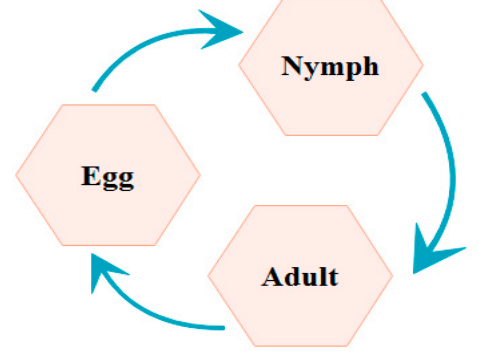
Figure 4. The life cycle of grasshoppers [1].